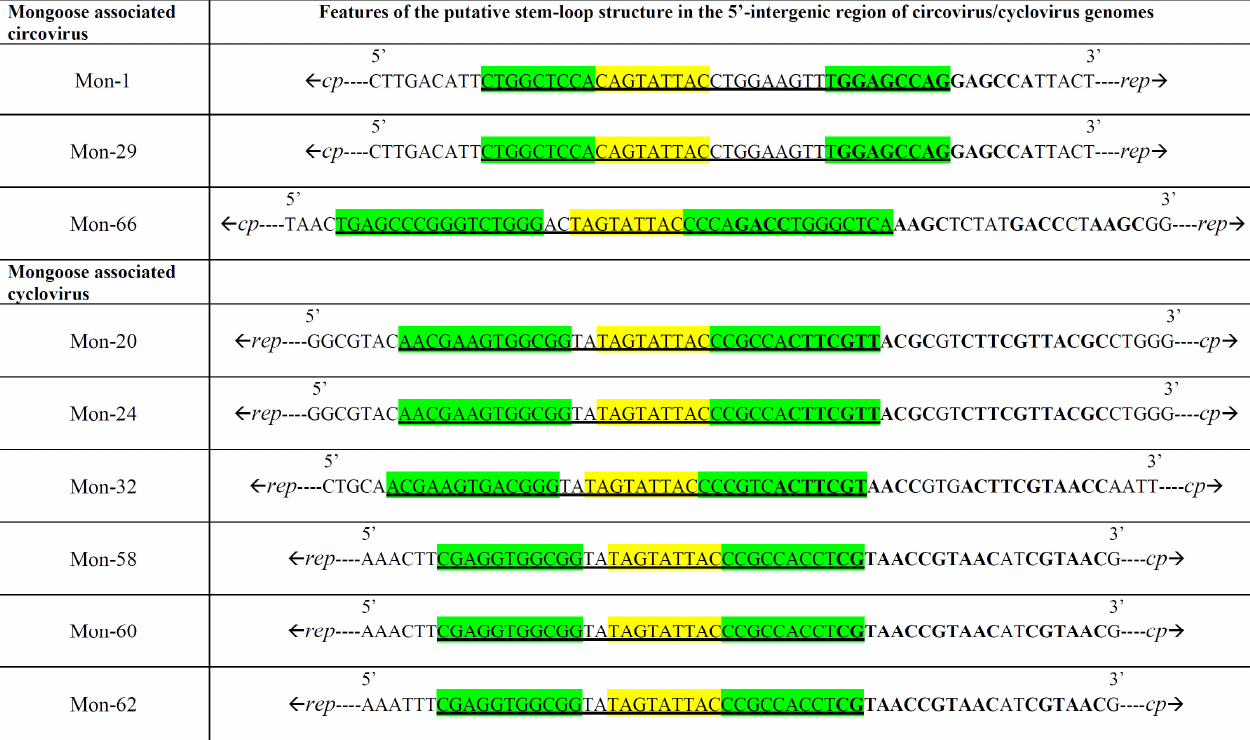
Figure 3. Potential stem-loop structures found in the 5 ′ -intergenic region of mongoose associated circovirus and cyclovirus genomes. The putative stem-loop sequence is underlined. The nonanucleotide motif is shown with yellow. The comple- mentary regions of the nucleotide sequence constituting the ‘putative stem’ are highlighted with green. The tandem repeat motifs are shown with bold font. rep : replicase gene; cp : capsid gene.